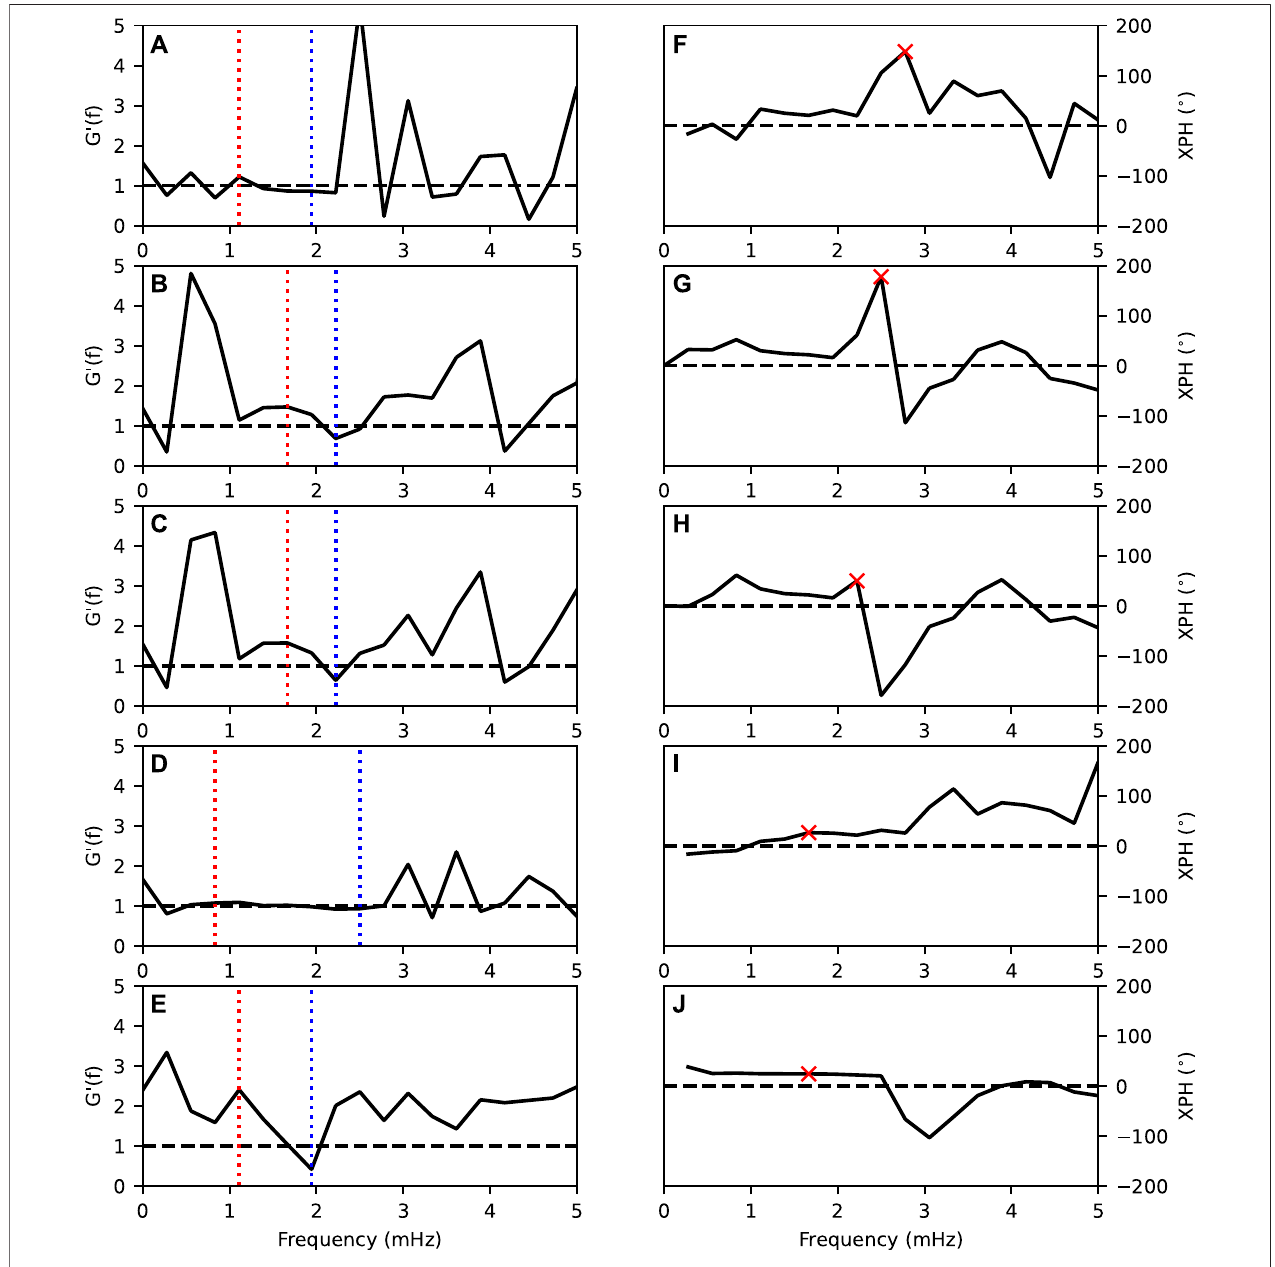
FIGURE2| Correctedspectralamplituderatio, G ′ ( f ),andcross-phasebetweenGIMandISLforthe25November,2001intervalforeachofthe fi vedataprocessing methods. (A – E) correspond to G ( f ) for the boxcar, Hann, Hamming, exponential taper, and multi-taper methods respectively, with the red (blue) dashed line correspondingtothefrequencyof G +(−) ′ . (F – J) arethematchingcross-phasesforthespectralamplituderatios,withthecross-phaseattheresonantfrequencyindicated by red crosses.